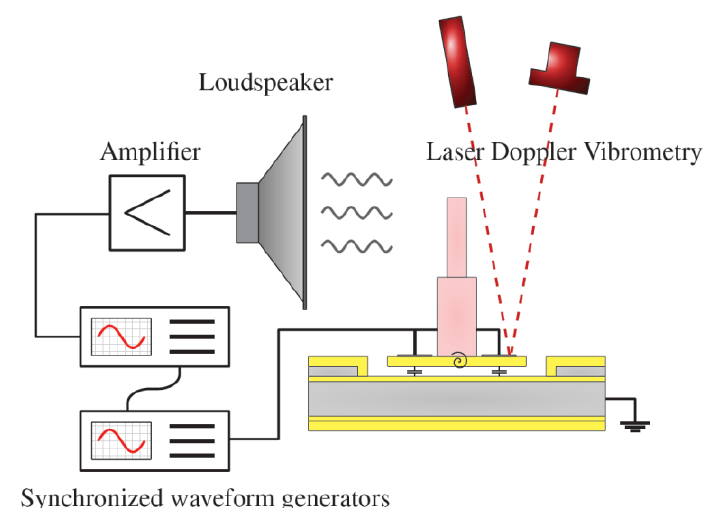
Figure 5. Measurement setup for determining the membrane displacement of the hair flow